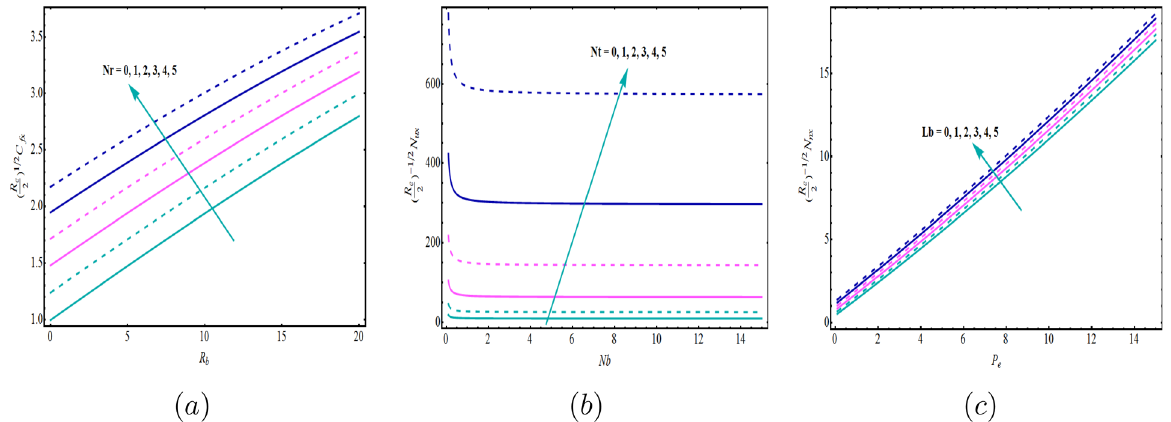
Figure 2. Variations for ( a ) SFC, ( b ) LNN, ( c ) LDMM with R b , Nb , P e with various values of Nr , Nt and P e , respectively.